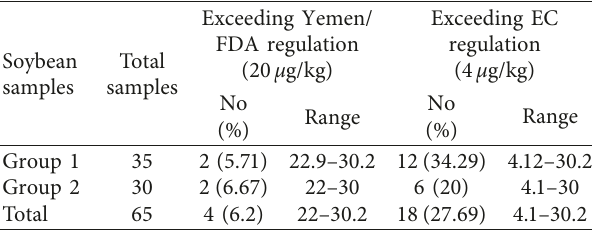
Table 3: Total aflatoxins in soybean samples exceeding the